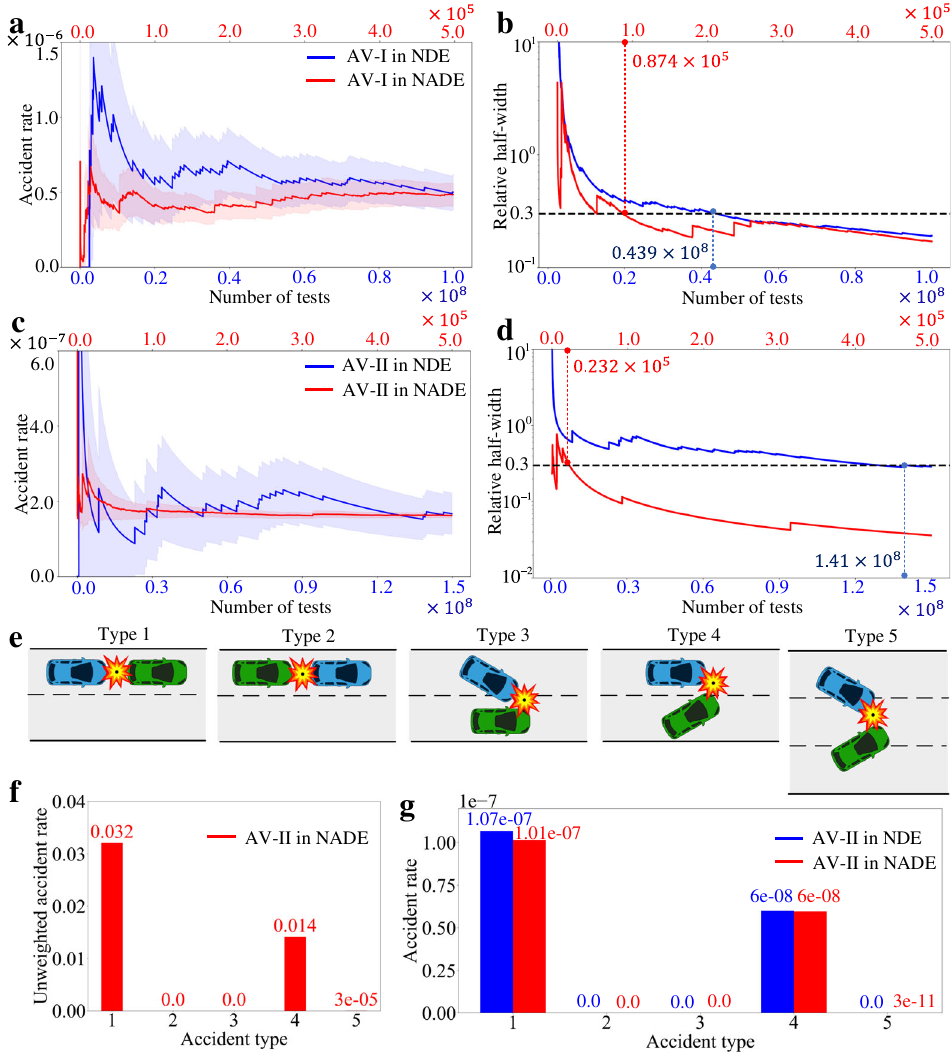
Fig. 7 Evaluation accuracy and ef fi ciency for the two AVs by NDE and NADE. The accident rate estimation of the AV-I model ( a ) and the AV-II model ( c ). The relative half-width of the AV-I model ( b ) and the AV-II model ( d ). e Illustration of the fi ve accident types. Type 1: the autonomous vehicle (AV, blue vehicle) has a rear-end collision with the background vehicle (BV, green vehicle). Type 2: the BV has a rear-end collision with the AV. Type 3: the AV makes